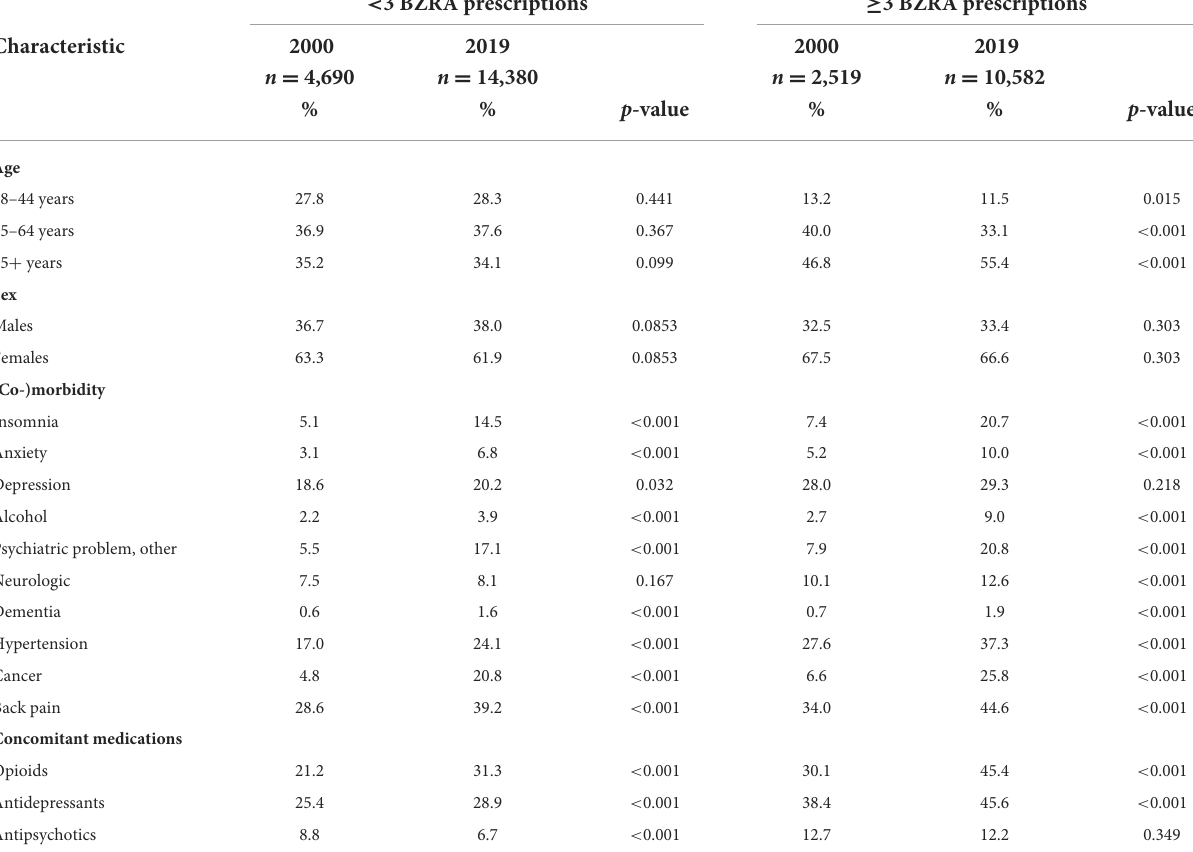
TABLE 1 Sample characteristics based on BZRA prescription rates in 2000 and 2019.